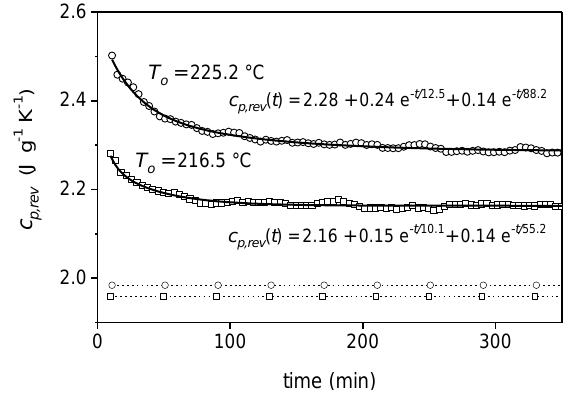
Figure 14. Time dependence of the reversing specific heat capacity ( c p,rev ) of PBT isothermally crystallized at 200 °C for 30 min, during quasi-isothermal measurements over long time periods in the melting region at T o = 216.5 °C (□) and 225.2 °C ( ○ ) ( p = 120 s, A T = 0.2 K). The dashed lines with squares and circles are the c p,base,2phase values calculated by Equation (3) from the crystallinity degrees measured at the end of the quasi-isothermal annealing at T o = 216.5 °C and 225.2 °C, respectively, by using the solid and liquid specific heat capacities of PBT as taken from [40]. (Reprinted (adapted) with permission from [73]. Copyright (2004) American Chemical Society).